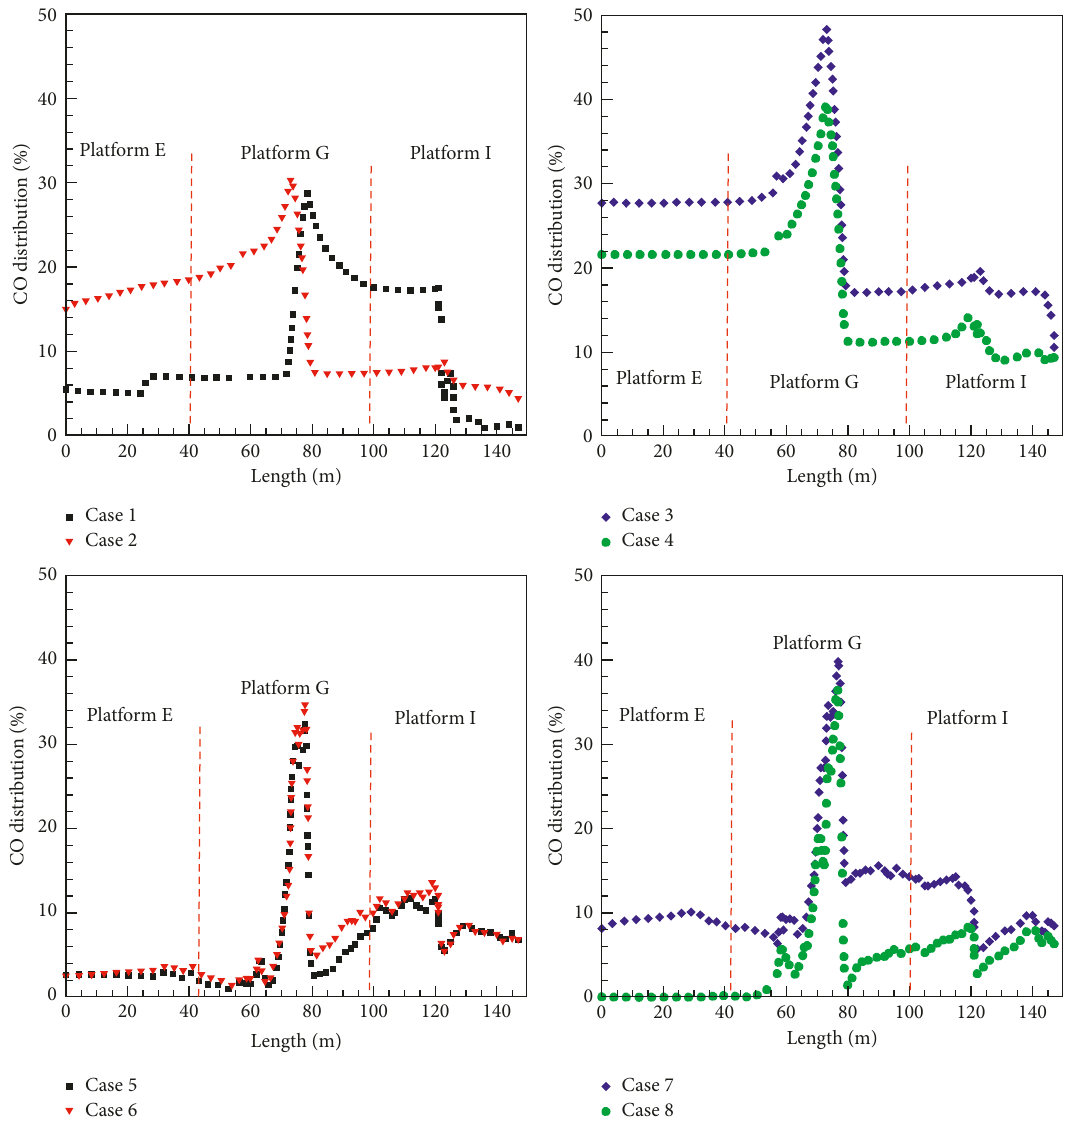
Figure 5: CO distributions of platforms E, G, and I at the height of